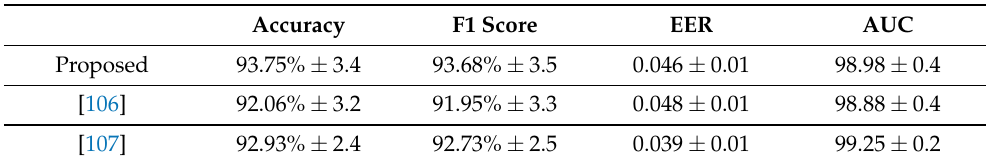
Table 3. The obtained results in terms of the Accuracy, F1 Score, Equal Error Rate (EER) and Area Under the Curve (AUC)